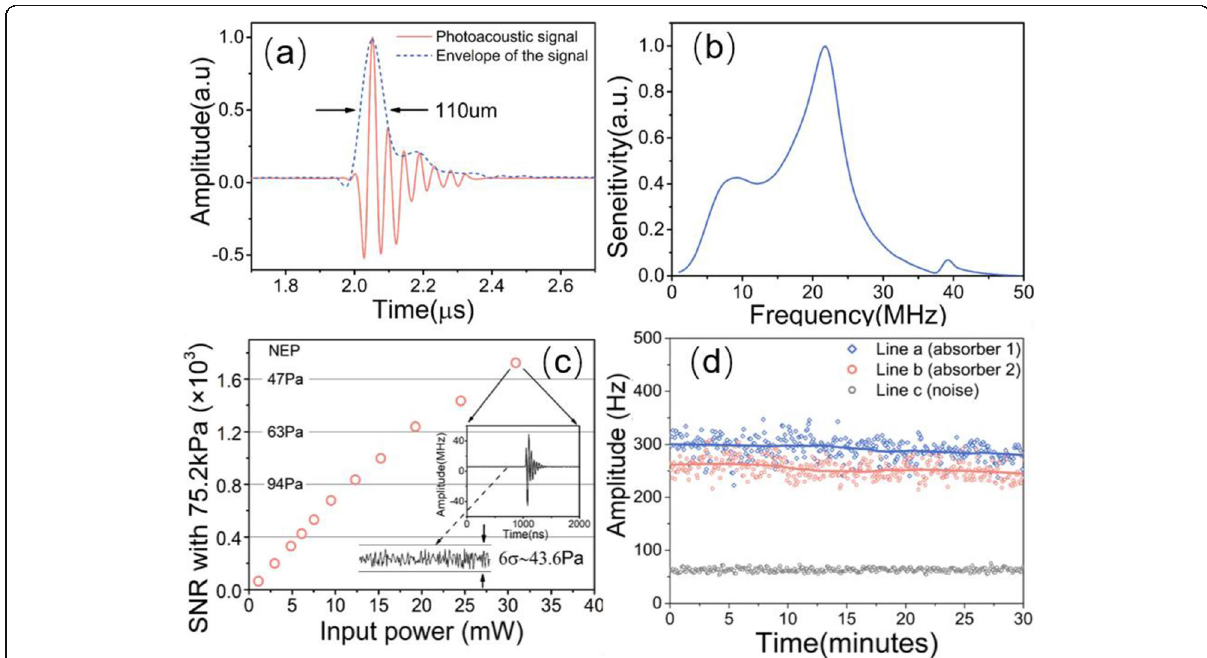
Fig. 8 a and b : Temporal ( a ) and frequency ( b ) response of the sensor; ( c ) Measured noise equivalent pressure as a function of input power at the photodetector; and ( d ) Stability test result by continuously measuring the photoacoustic signals from two discrete absorbers for over 30 min